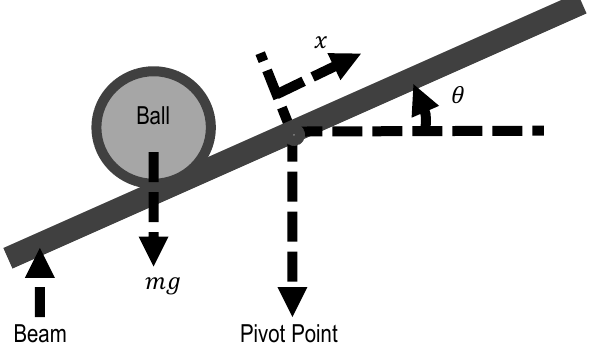
Fig. 1. Illustration of ball and beam system